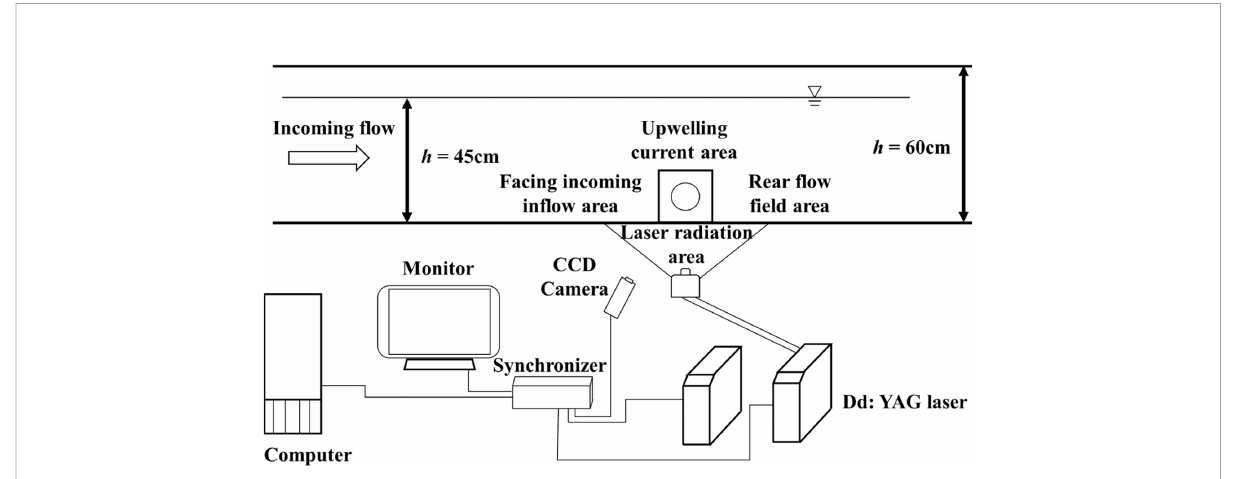
FIGURE 3 A schematic illustration of the experimental apparatus and the PIV